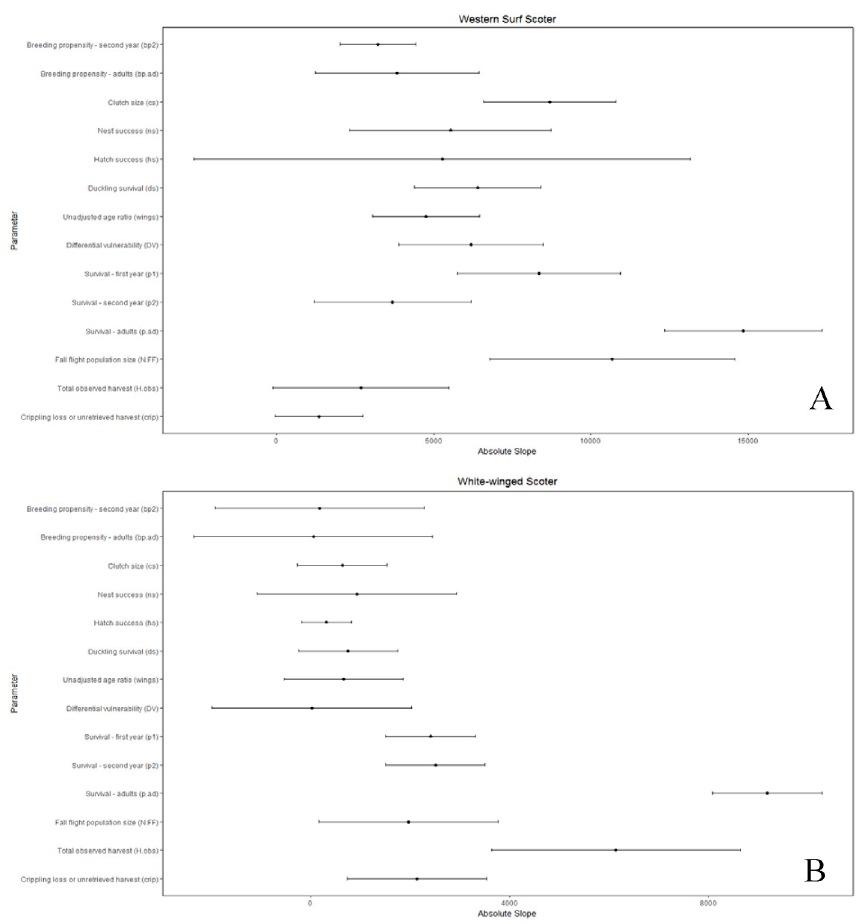
Fig 5. Sensitivity of the difference between allowable and observed harvest to individual demographic parameters as measuredby the slope of linear relationships between the harvest difference and standardized values of the demographic parameters, where greater absolute slope indicates higher sensitivity. Slope is affected by both the inherent sensitivity of growth rate and, hence, allowable harvest, to each parameter and its relative proportional uncertainty. Bars reflecting relative proportional uncertainty represent the coefficient of variation for non-binomial parameters or concentration for binomial parameters and, in both cases, have been multiplied by 100 (divided by 1000 for eiders) for scaling and presentation purposes. (A) western surf scoter, (B) white-winged scoter.